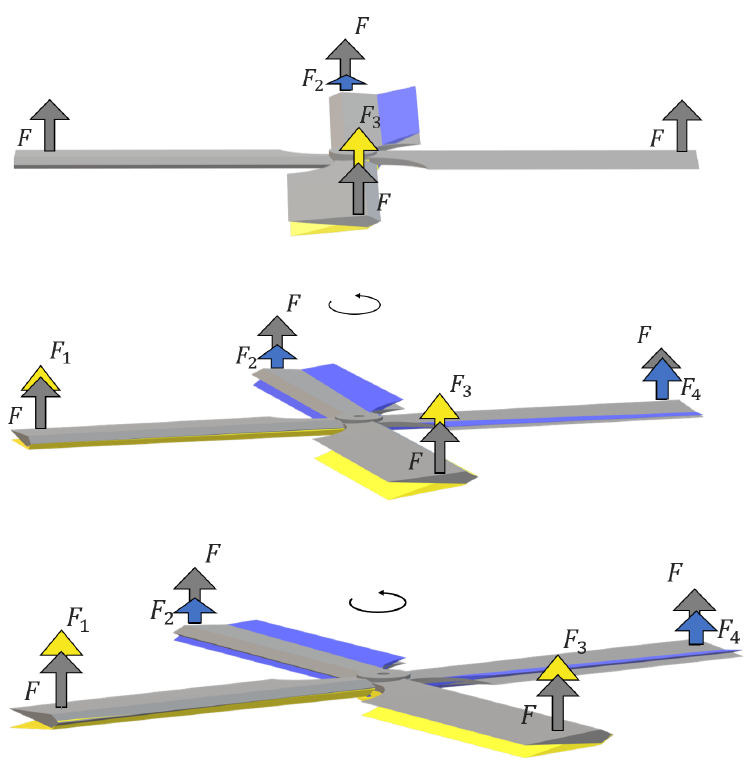
Figure 3. Series of frames representing the rotation of the main rotor actuated by the Cyclic control . The artwork shows the forces exerted by each blade during a rotation. The grey arrow denotes the force F produced when the blade is horizontal, whereas the yellow (blue) arrows denote the forces produced when the angle taken by the blade is such that the thrust is stronger (weaker) than F .